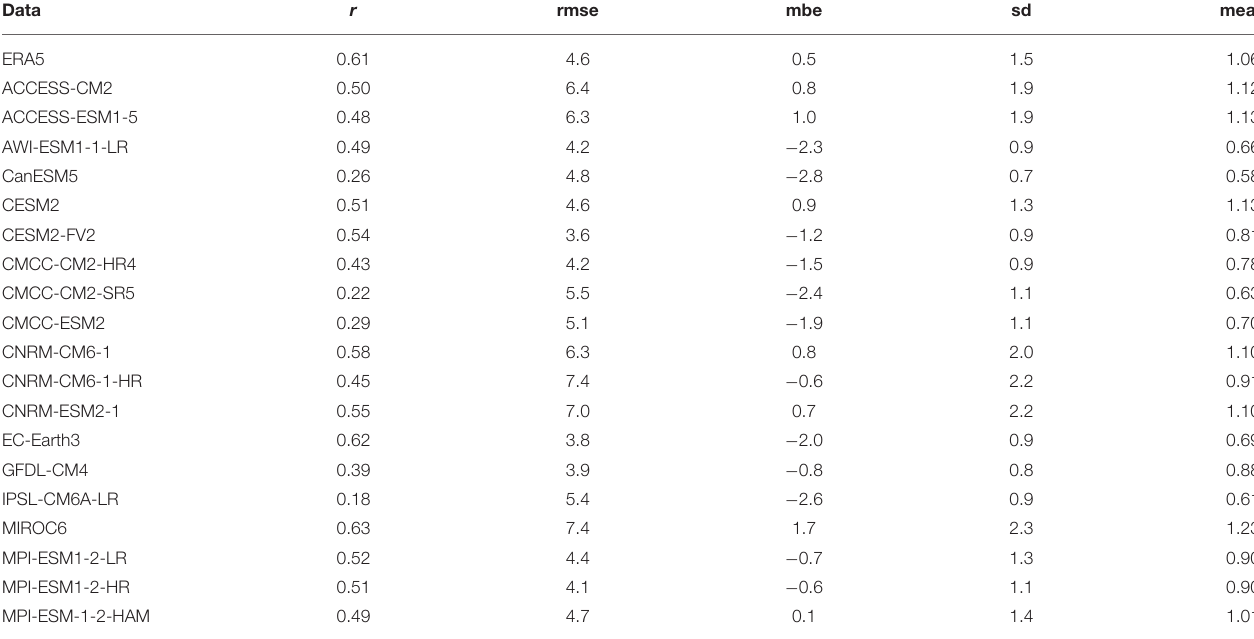
TABLE 2 | The statistical metrics to evaluate variance of rainfall from ERA5 and CMIP6 climate models relative to GPCP. Data r rmse mbe sd